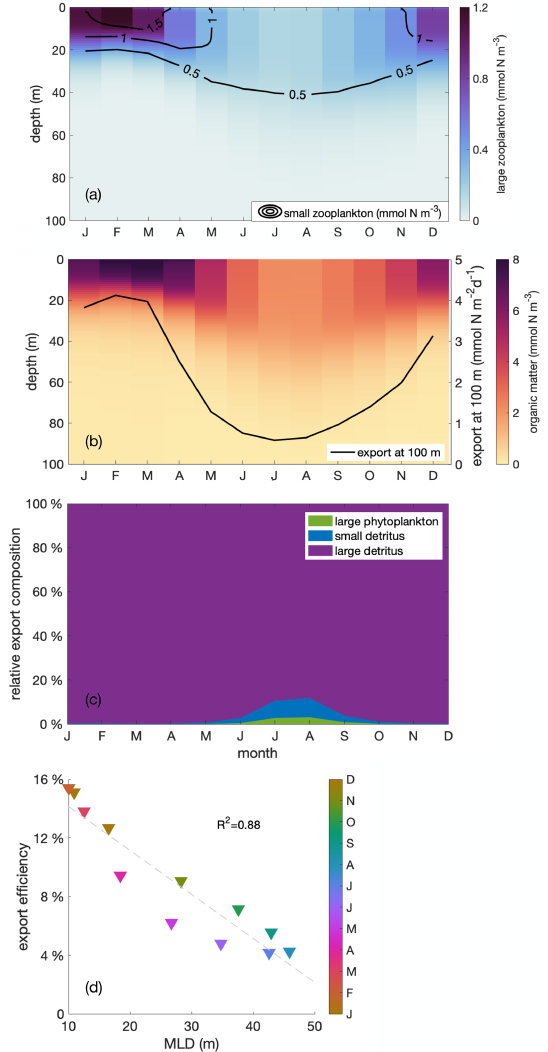
Figure 7. Monthly depth distribution of (a) large and small zoo- plankton (in colours and contour lines, respectively) and (b) organic matter with the seasonal cycle of vertical export through the 100m depth horizon (black line), (c) seasonal cycle of the relative contri- butions to sinking organic matter from large phytoplankton (green) and small (blue) and large (purple) detritus, (d) correlation of ex- port efficiency with mixed layer depth (MLD) within the focus re- gion. The export efficiency is defined as the ratio of export through the 100m depth level to primary production in the upper 100m. Colours indicate the month of the